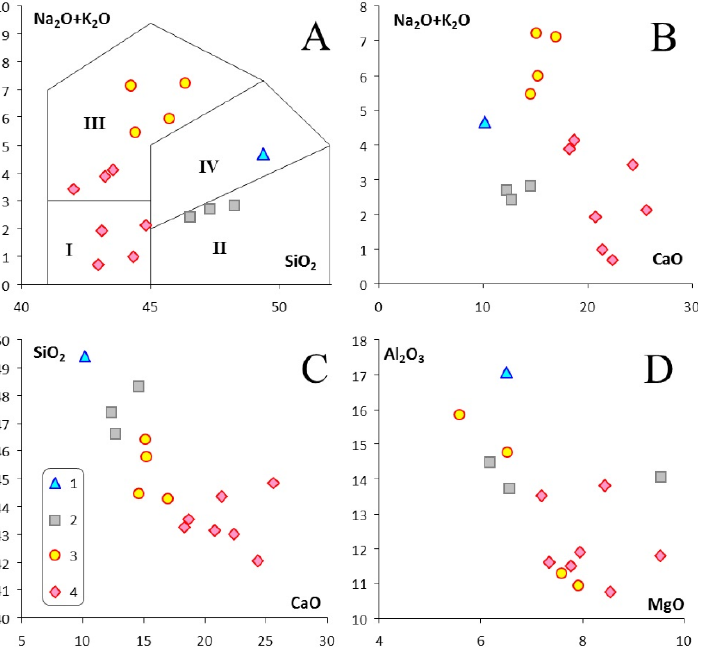
Figure 8. Tazheran rocks in variation diagrams. Fields of intrusive rocks in panel A are after [27], complemented by Lavrenchuk et al. [28]: I = peridotite, II = gabbro, III = feldspar gabbro, IV = monzogabbro. Dolerite (1), beerbachites (2), nepheline-fassaite rocks (3), pyroxenites (4). ( A ) (Na 2 O+K 2 O)-SiO 2 ; ( B ) (Na 2 O+K 2 O)-CaO; ( C ) SiO 2 -CaO; ( D ) Al 2 O 3 -MgO.